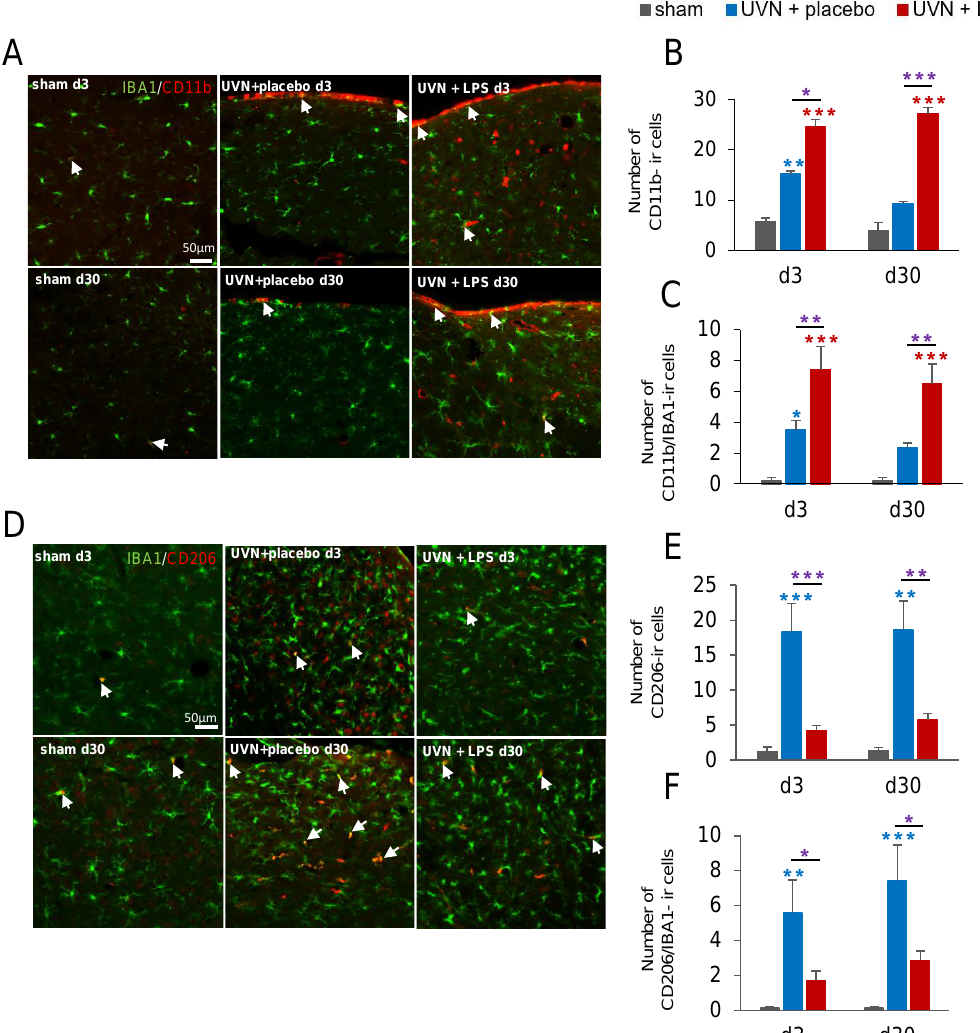
Figure 3. Expression of M1 proinflammatory and M2 anti-inflammatory phenotypes in the me- dial vestibular nuclei (MVN) are modified by the acute LPS treatment after UVN. ( A ) Confocal visualization of CD11b (M1 phenotype) and IBA1 (microglial cells) stainings in the left MVN of a representative animal in sham, UVN+placebo, and UVN+LPS groups at d3 and d30 post-UVN. Colocalization of both markers is represented by the merged color and examples are indicated by white arrows. ( B ) Quantification of the number of CD11b-immunoreactive (ir) cells in left MVN at d3 and d30. ( C ) Quantification of the number of CD11b/IBA1-ir cells in the left MVN at d3 and d30. ( D ) Confocal visualization of CD206 (M2 phenotype) and IBA1 (microglial cells) stainings in the